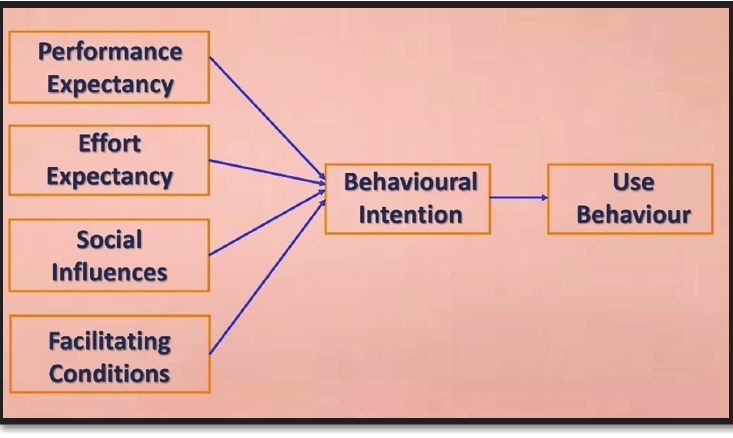
Fig. 3. The UTAUT framework– for technological and value issues (Adapted from Venkatesh et al . ,